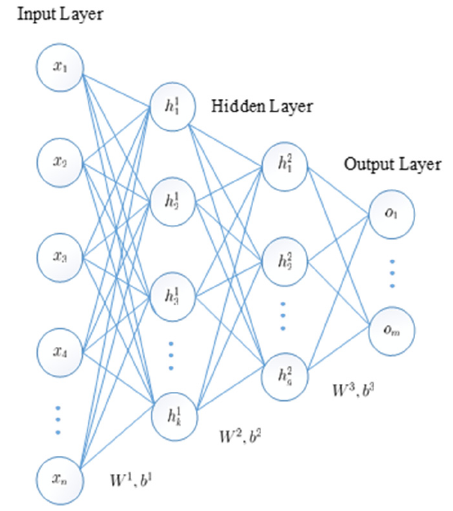
Figure 2. Stacked autoencoder (SAE) structure.